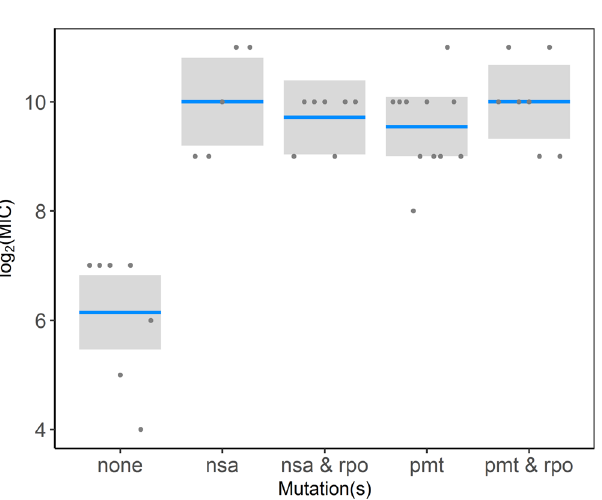
Figure 1. Growth parameters of experimentally evolved AMP-resistant S. aureus in relation to treatment (Vmax, lag phase, maximal OD) (blue line: mean, grey box: 95% confidence intervals).